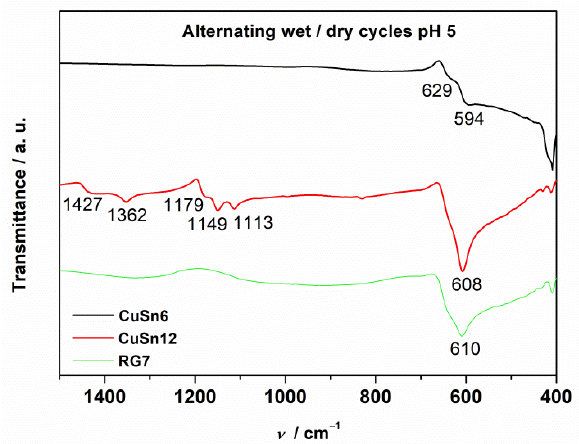
Figure 13. FTIR spectrum for alternating wet/dry cycles in acid rain at pH 5.